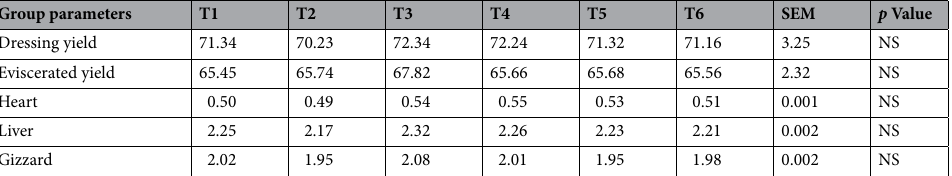
Table 1. Effects of dietary inclusion of prebiotics on carcass characteristics and organ weight (% of live weight) in broiler chickens. T bearing the same superscript in a row did not differ significantly ( p < 0.05).